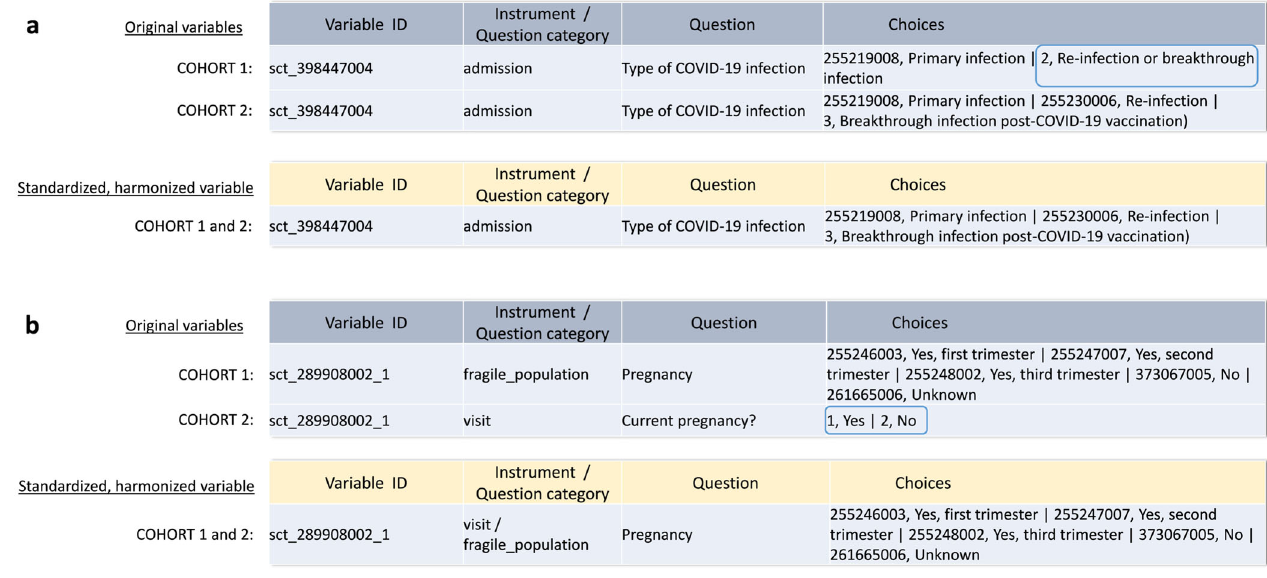
Fig. 9 Harmonization of value sets for two common variables. a , b show how different answer value sets between two clinical studies in ORCHESTRA converged to maximize precision and interoperability.